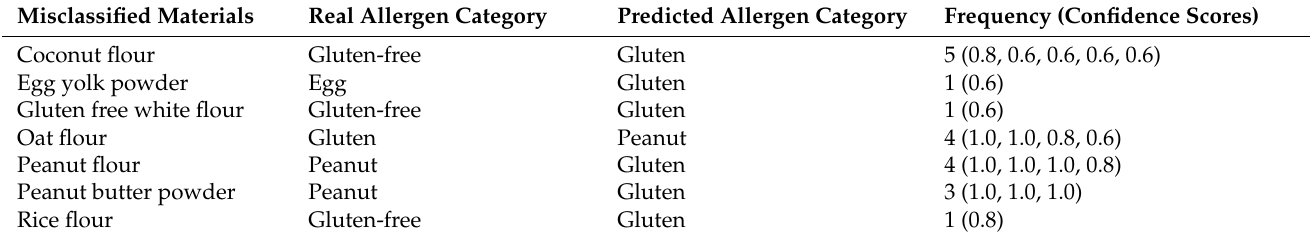
Table 4. A breakdown of the incorrectly predicted allergen classes for the ensemble model. The ensemble model consisted of five networks. As a case study, the networks were trained using both SGAN and DANN methods and both sensor measurements to predict for the fast speed with no labelled data from the target domain.